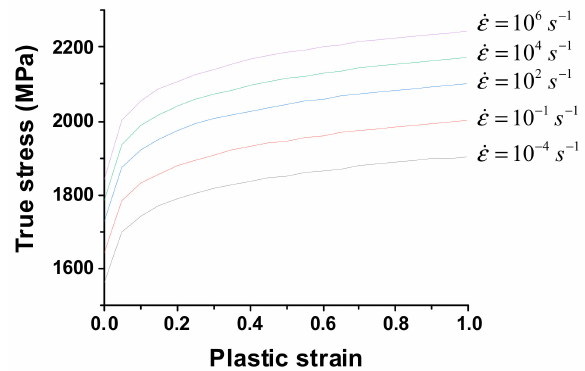
Figure 7. Material properties of vacuum-arc-remelted (VAR) 4340 with respect to strain rate [17].